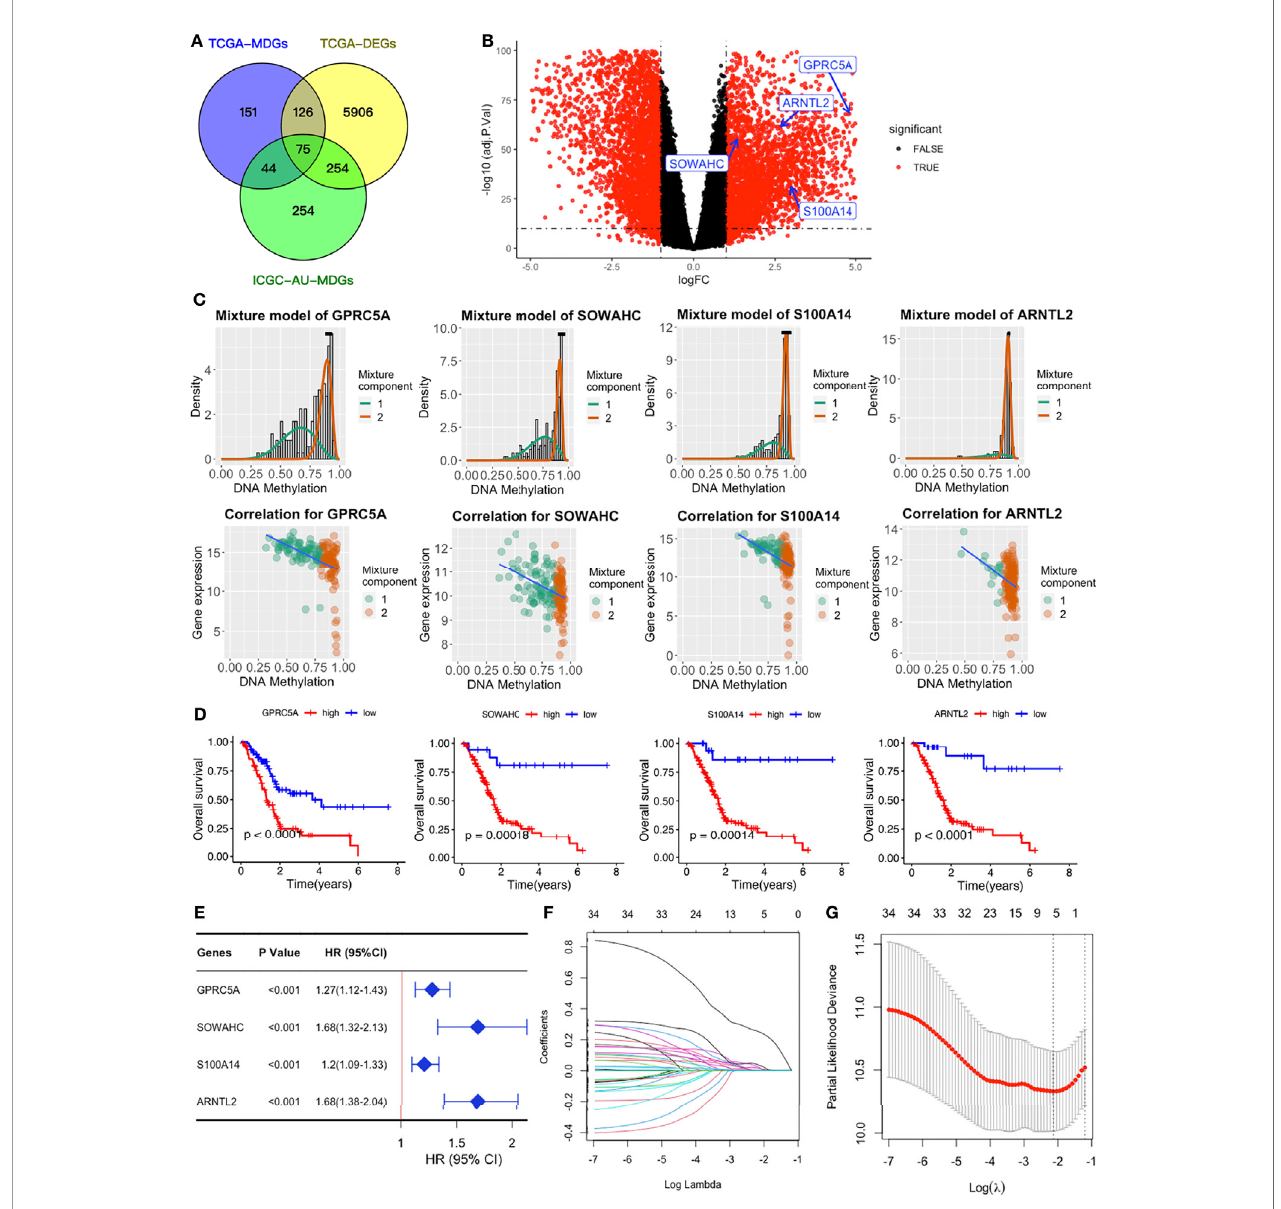
FIGURE 2 | Establishment of a four-MDG signature. (A) Venn diagram showing DEGs and MDGs from the TCGA and ICGC datasets. (B) Volcano plot of DEGs with the four-MDG signature gene marked. (C) Distribution maps showing the degree of methylation degree (the top row) of the four signature genes and their correlation plots (the bottom row) between mRNA expression and DNAm levels. (D) K-M curves for the four MDGs in the TCGA dataset. (E) Univariate Cox regression of the four signature genes in the TCGA dataset. (F) LASSO coef fi cient pro fi les of the 35 genes in the TCGA dataset. (G) Selection of the optimal parameter (lambda) in the LASSO